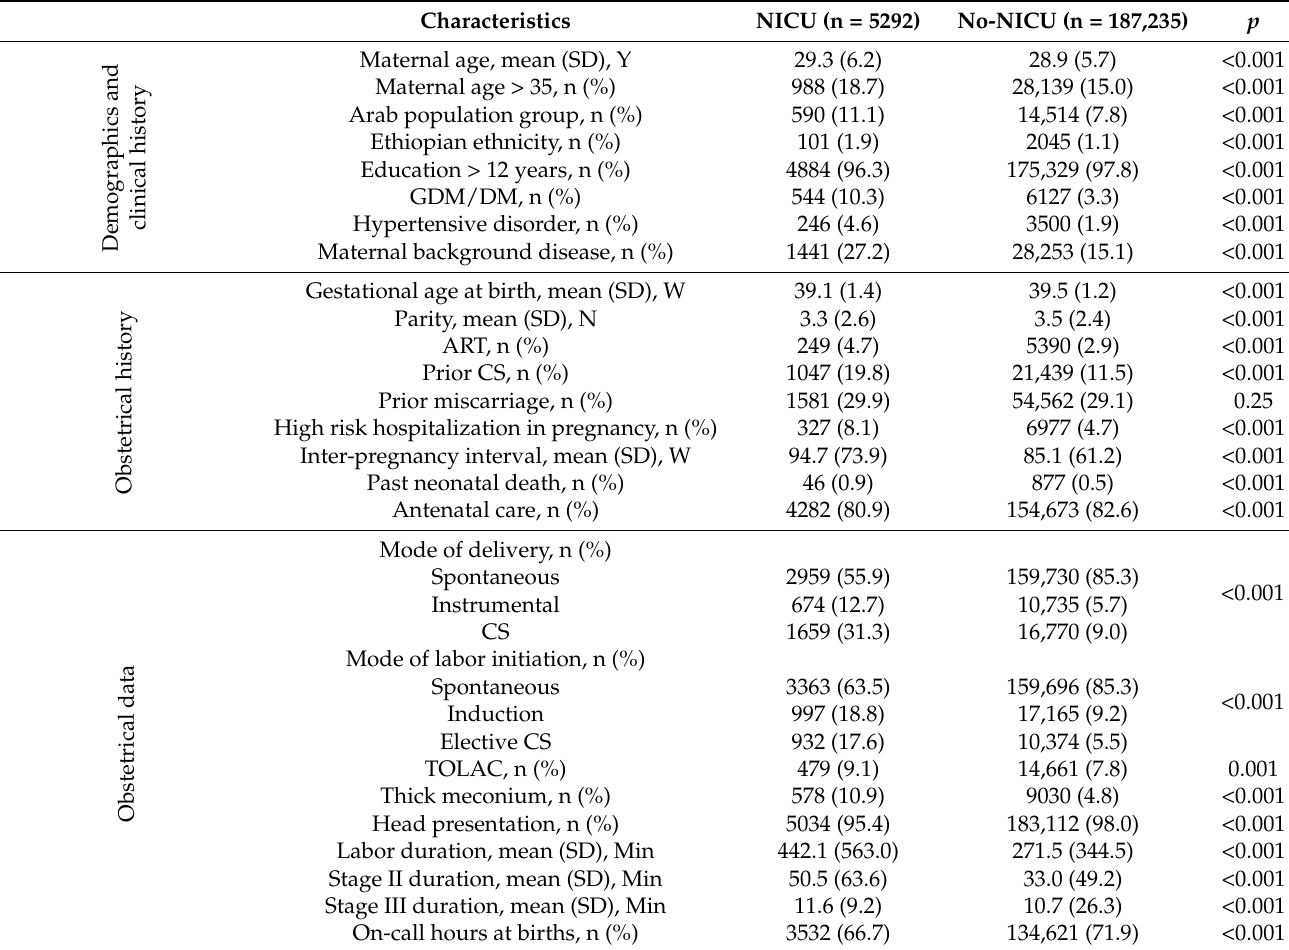
Table 1. Demographic, obstetrical, and neonatal characteristics of the study groups.